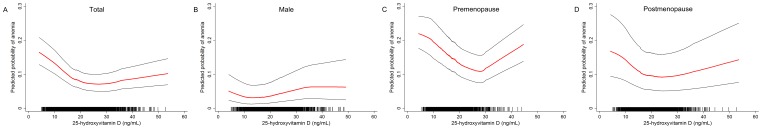
Predicted probability of anemia according to the serum 25-hydroxyvitamin D levels.Total subjects (A), males (B), premenopausal females (C), and postmenopausal females (D). Red and black lines represent predicted probability of anemia and 95% confidence interval, respectively.